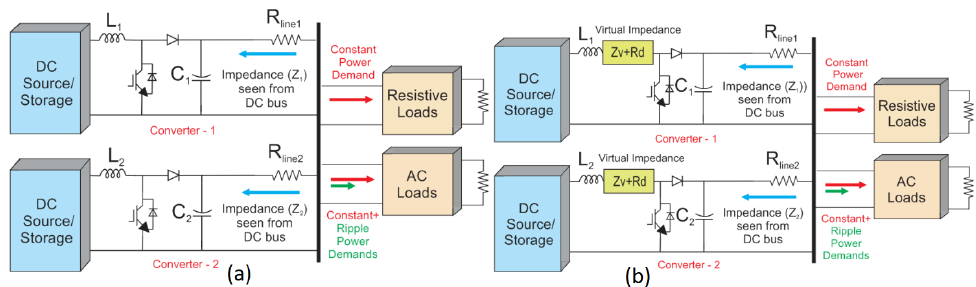
Figure 1. Impedance of node in microgrid ( a ) Without droop and virtual impedance Zv. ( b ) With droop Rd and Zv, if the Z 1 > Z 2 ripple in node-2 will be more. This is regulated using Rd and Zv